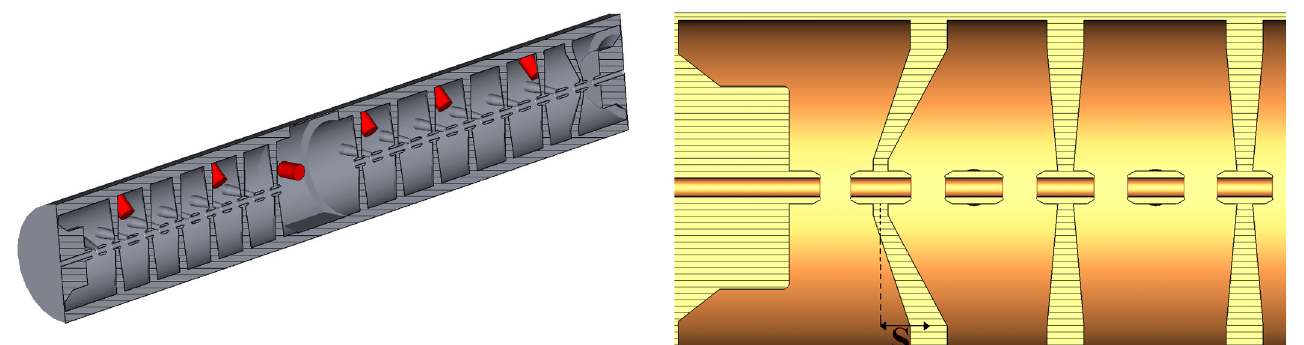
stem.FIG. 37. Cross sectional view of cavity 2 of the GSI proton injector showing the position of the inductive tuners.